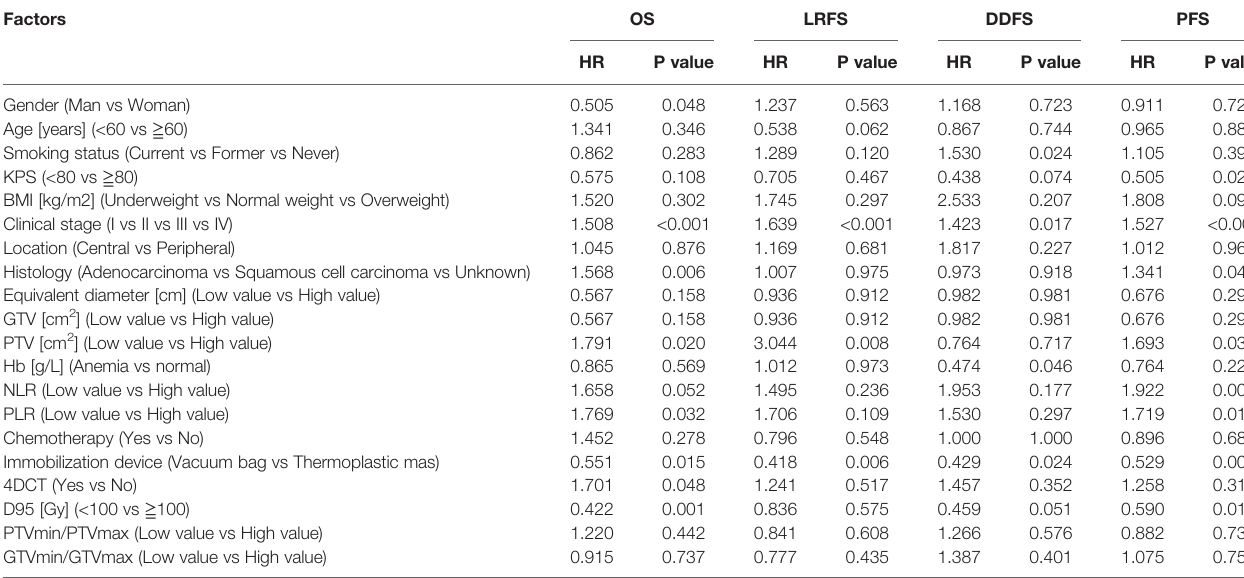
TABLE 3 | The univariate analysis of clinical and dosimetric predictive factors for OS, LRFS, DDFS and PFS in lung cancer patients treated with SBRT. Factors OS LRFS DDFS PFS HR P value HR P value HR P value HR P value Gender (Man vs Woman)